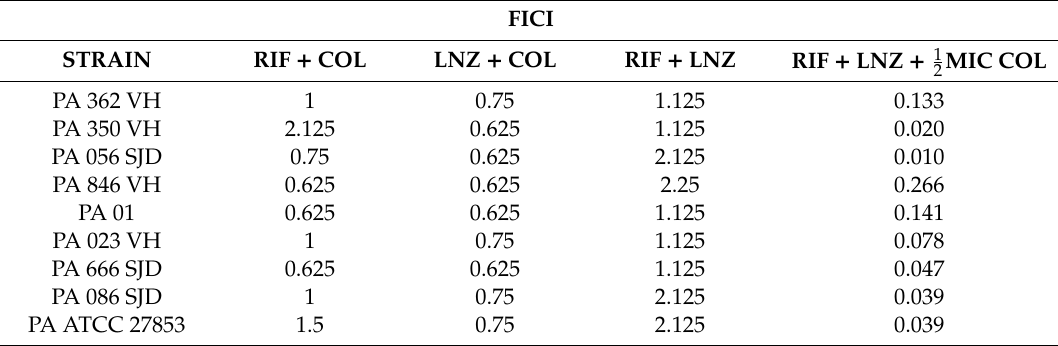
Table 4. Checkerboards of the di ff erent antibiotics used in this study, with their FICIs in MDR P. aeruginosa